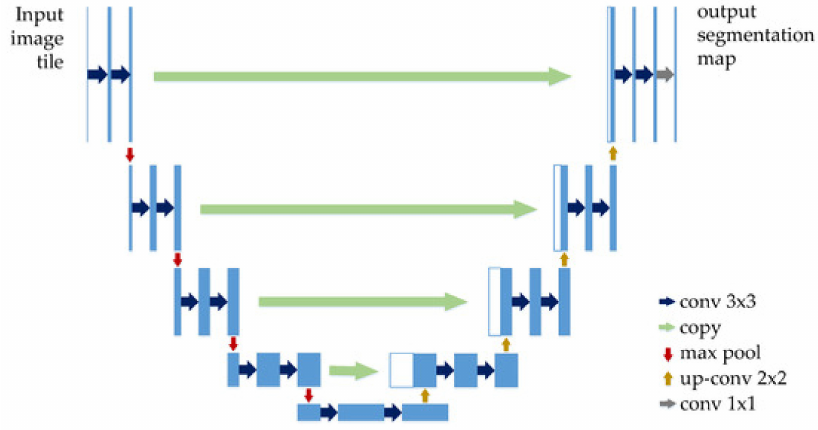
Figure 21. U-Net architecture